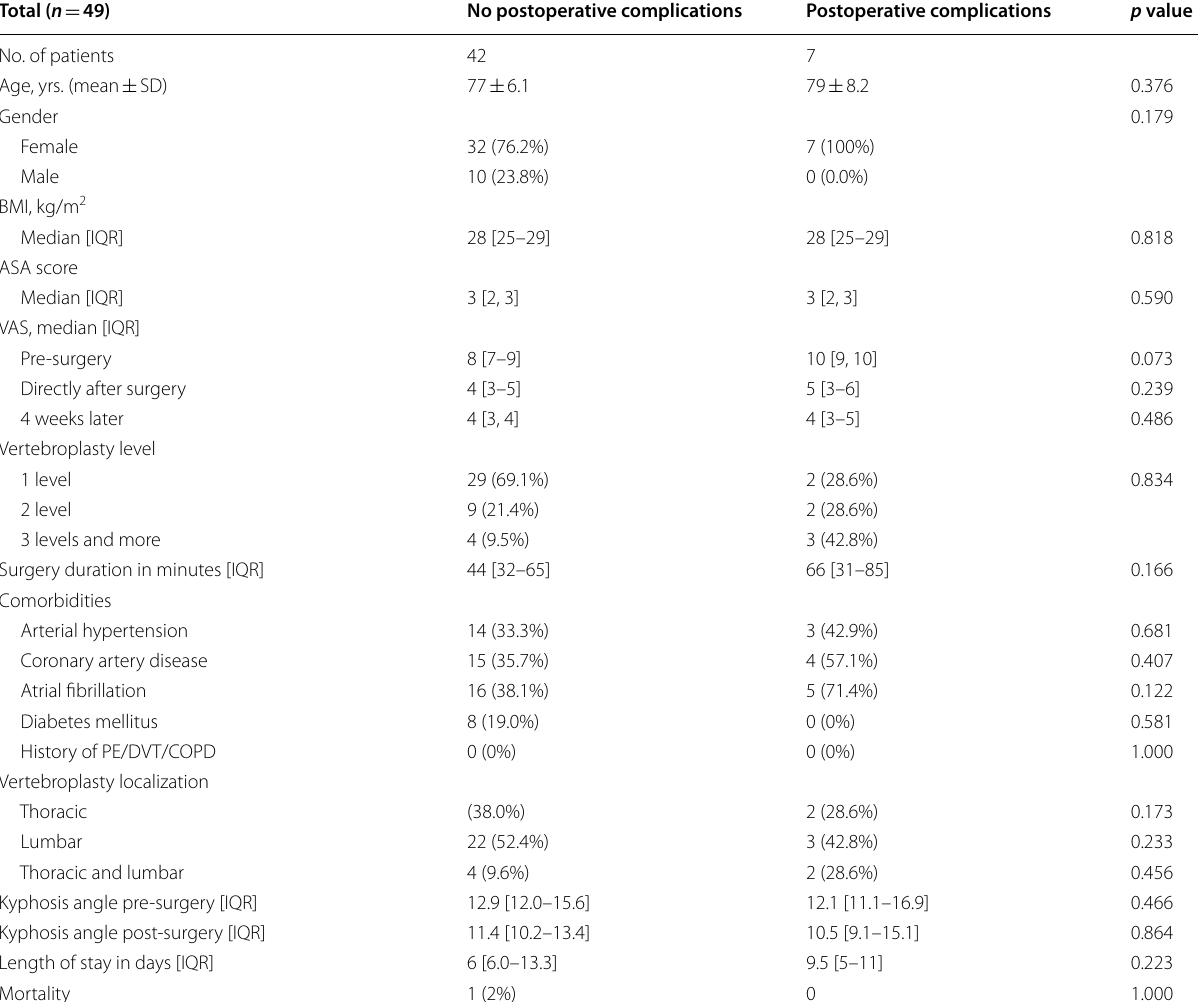
Table 2 Patient-related factors influencing complications after